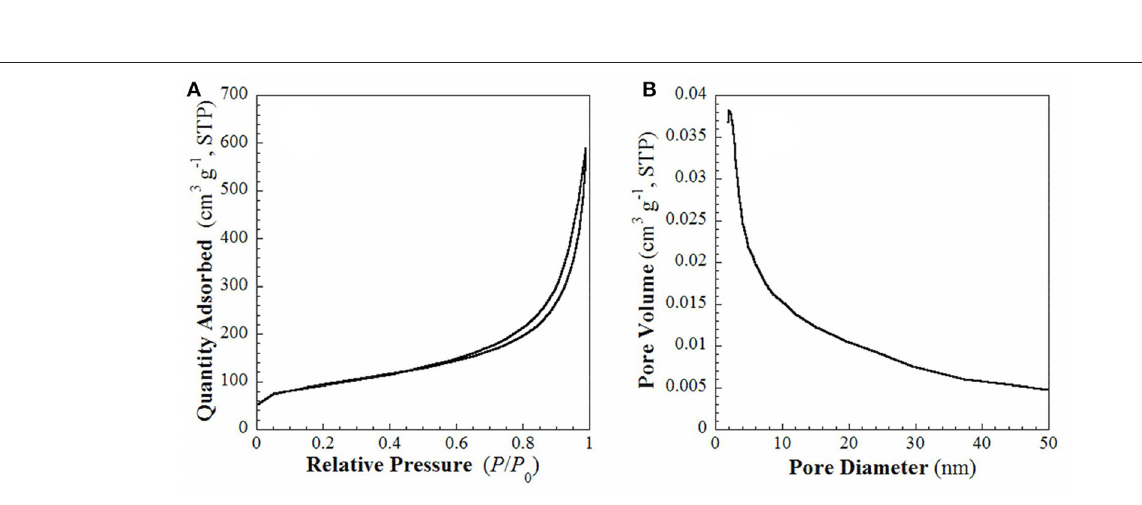
Frontiers in Chemistry | www.frontiersin.org